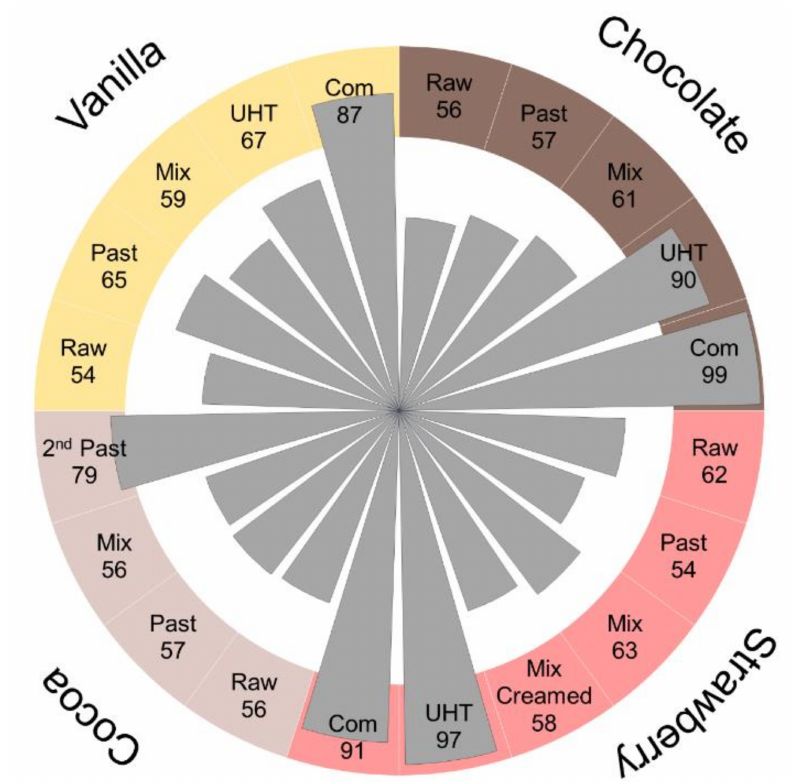
Figure 3. Overall numbers of modified peptides identified in each sample grouped by drinks and processing steps. Samples included raw milk (Raw), pasteurized milk (Past), milk mixed with flavorings (Mixed), milk drink after a second heat treatment, i.e., high-temperature-short-time (HTST, 2nd past) for cocoa and UHT for the other three drinks, and the corresponding milk drinks bought in a supermarket